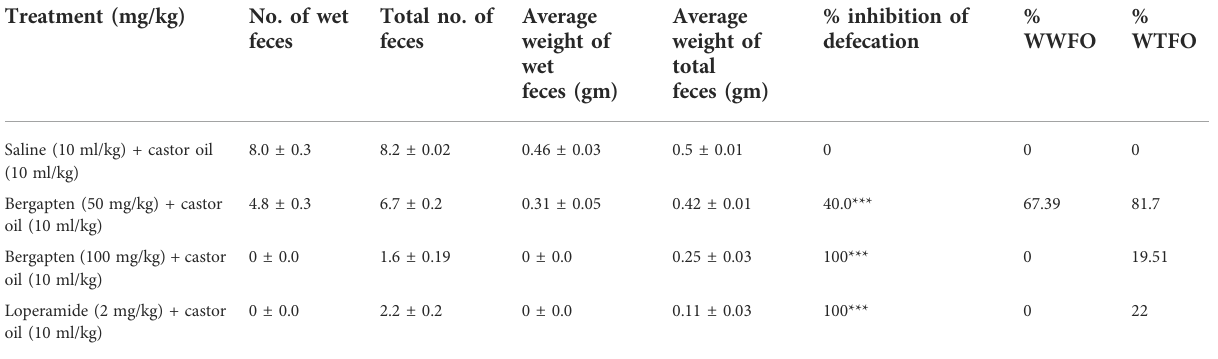
TABLE 1 Effect of bergapten and loperamide against castor oil-induced diarrhea in mice. Treatment (mg/kg)